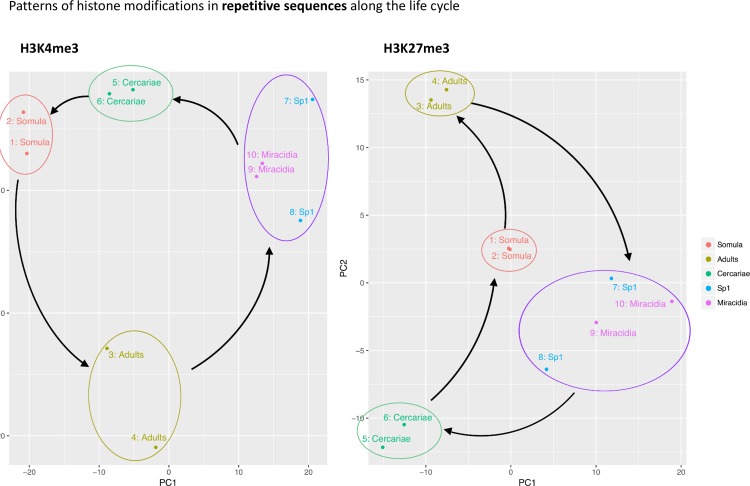
Principal component analysis (PCA) of ChIP enrichment for H3K4me3 (left) and H3K27me3 (right) over repetitive sequences.All life cycle stages segregate in the PCA but miracida and Sp1 (separated by 48 hours) are very close and could only be differentiated by H3K4me3 methylation. Arrows indicate developmental direction and are there to guide the eye.